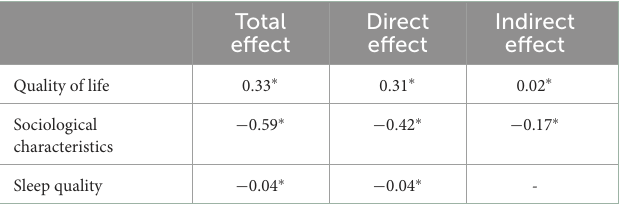
TABLE 6 Direct and indirect effects of quality of life and sleep quality on life